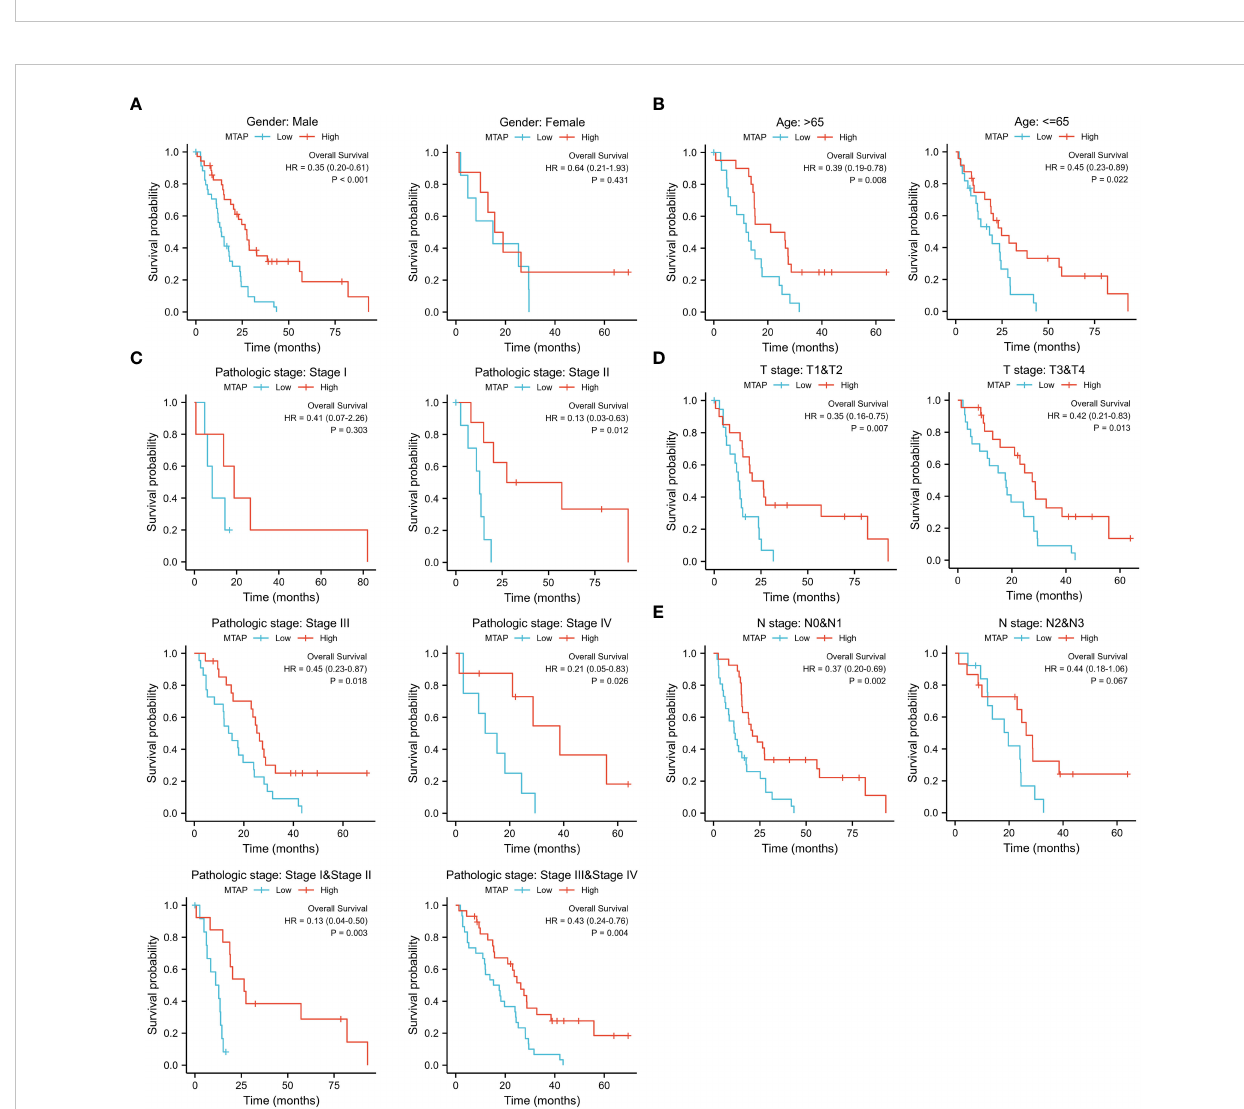
FIGURE 6 Subgroup prognostic analysis of MTAP gene in mesothelioma. (A) : Gender group; (B) : Age group; (C) : Pathological stage; (D) : Primary tumor stage (T stage); (E) : MPM regional lymph node metastasis stage (N